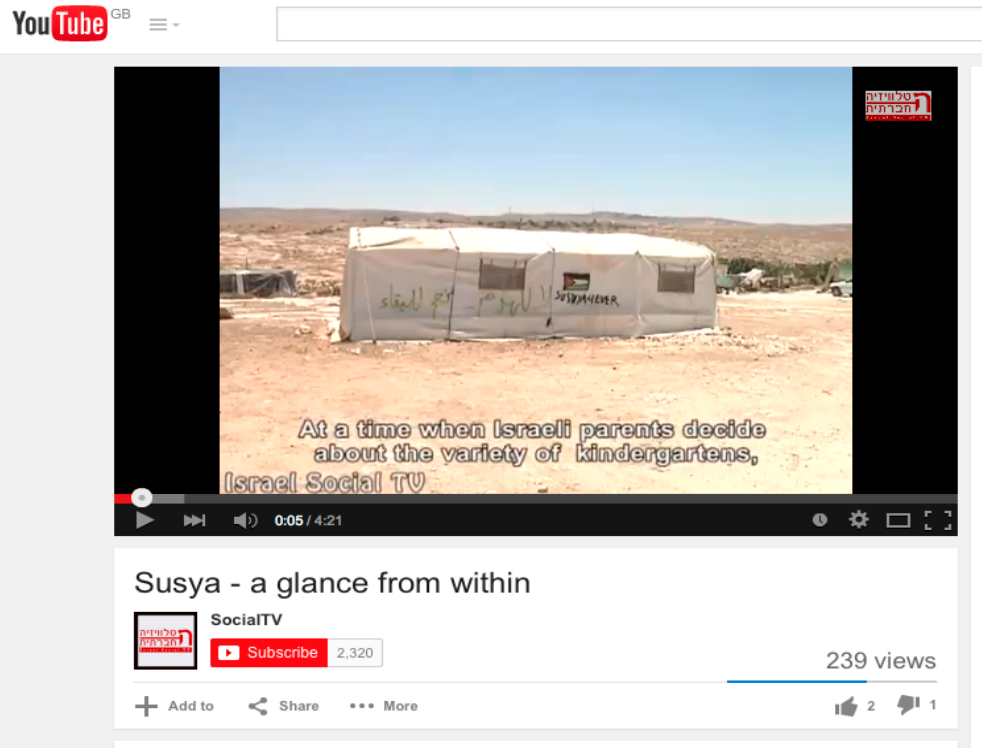
Figure 12. Screen grab from Social TV’s feature on Susiya—‘A Glance from Within’. (Accessed on 14 September 2015).